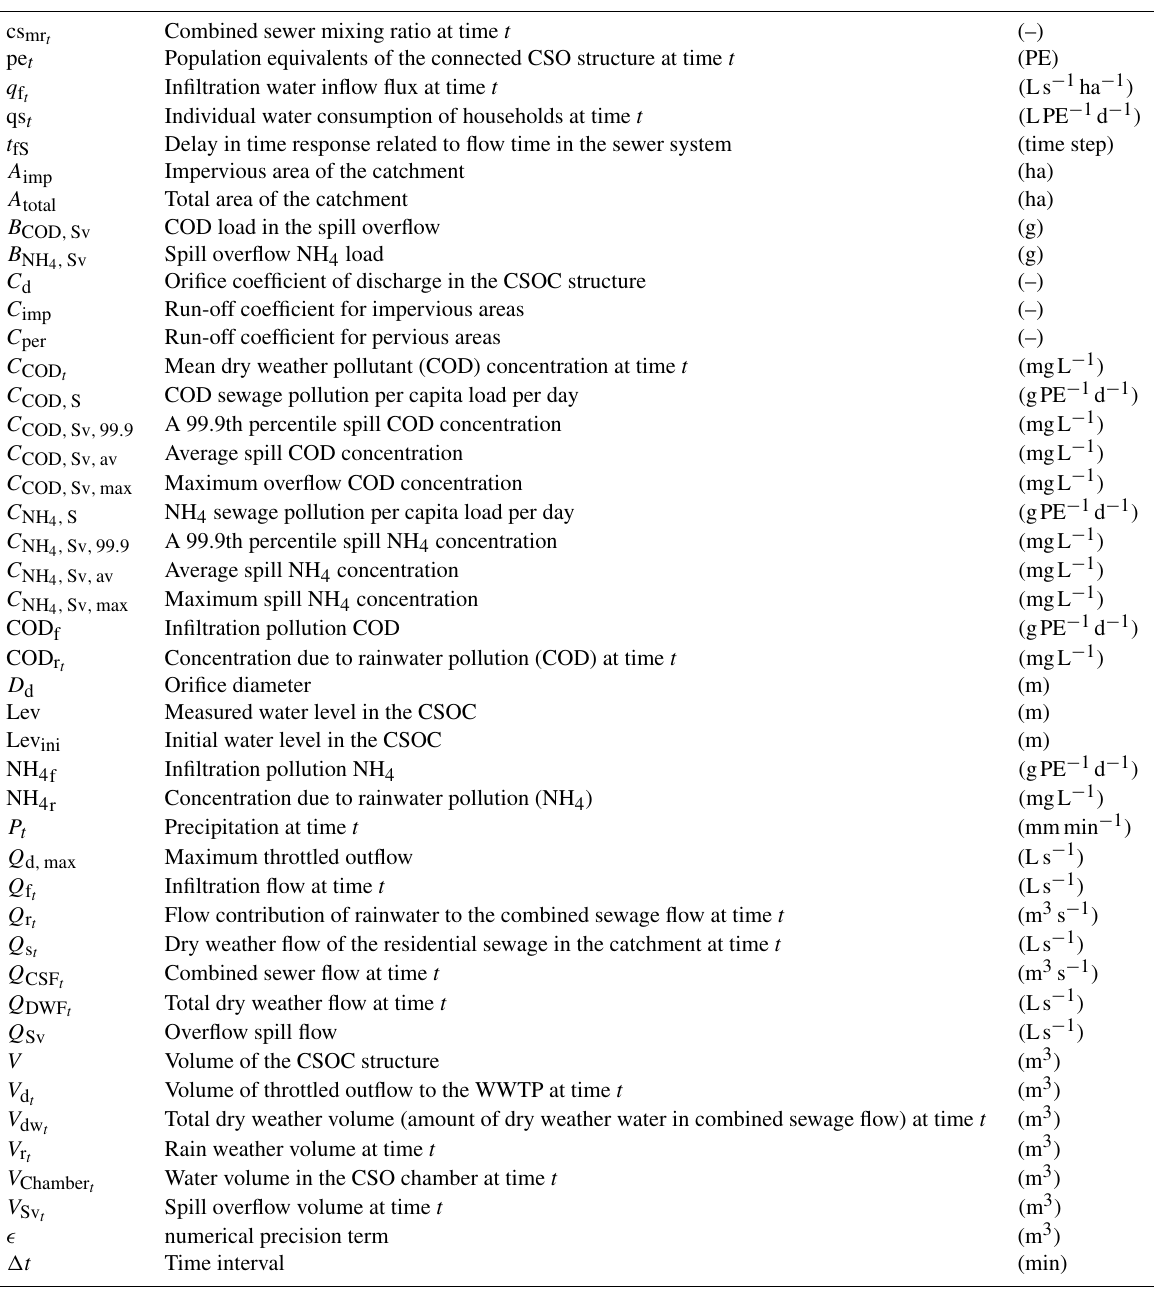
Table A1. List of variables of EmiStat R